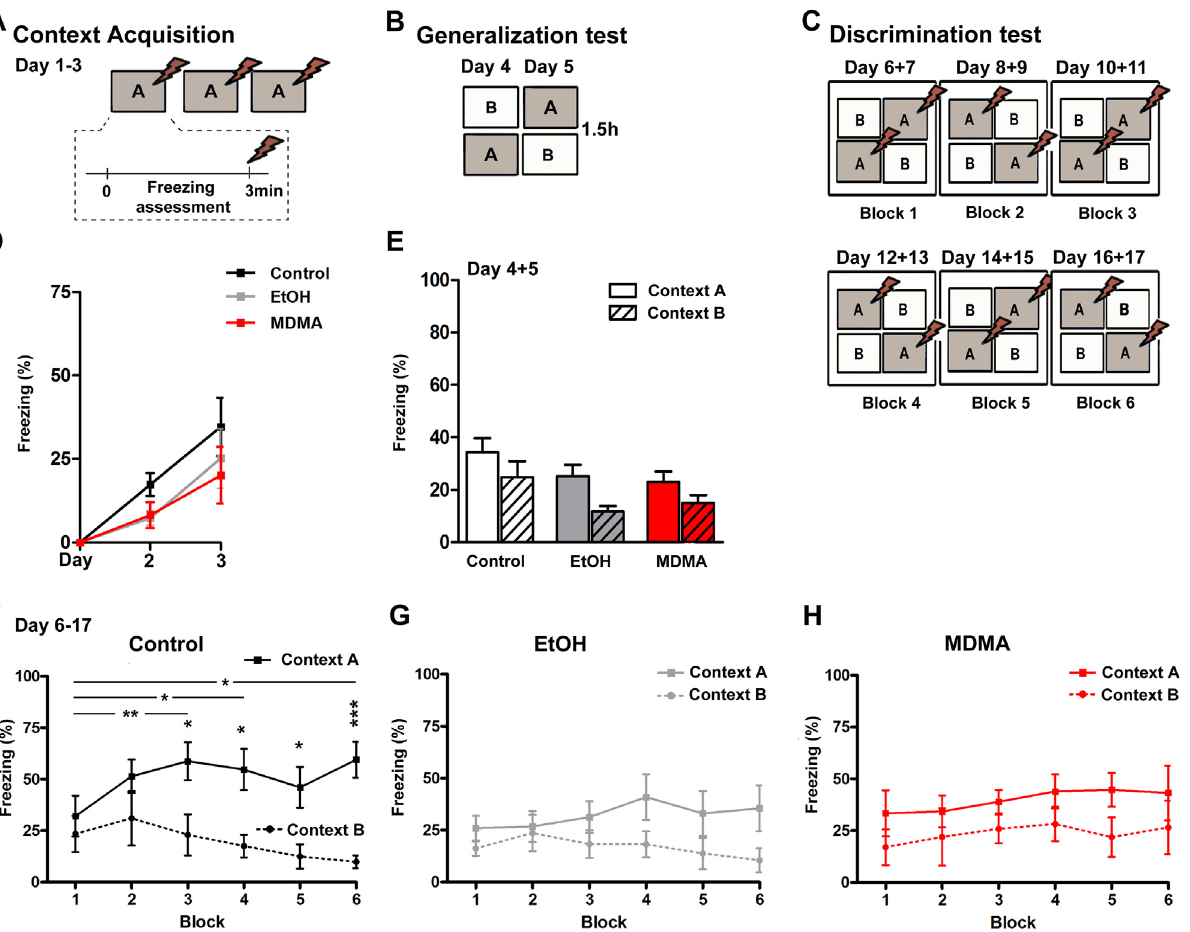
Fig 4. Influence of voluntary EtOH intake and high-dose MDMA (20 mg/kg x 2) on contextual fine discrimination. ( A, D ) Learning acquisition during days 1 – 3 was measured as freezing during 3 minutes before shock in context A. ( B, E ) Generalization, demonstrated as no significant difference in freezing between contexts A (no fill) and B (stripes), is shown for the Control (white bars), EtOH (grey bars) and MDMA (red bars) groups. ( C ) The discrimination test followed a double alternation schedule from day 6 – 17 and, to show graphic overviews, each 2 days were averaged together to make six blocks. ( F ) While control animals discriminate between the two contexts by day 10 (observed in block 3) of the discrimination task, both the ( G ) EtOH and ( H ) MDMA groups had impaired discrimination capacity, shown as no significant difference in the percentage of freezing time between contexts A (shock) and B (safe context). Data shown are the mean ± SEM (n = 6 mice/group). Statistically significant differences over time within each group and context are indicated by brackets and * ( p < 0.05) and ** ( p < 0. 01), and between context A and context B by * ( p < 0.05), *** ( p < 0.001; Bonferroni ’ s post hoc test). MDMA, 3,4-Methylenedioxymethamphetamine.